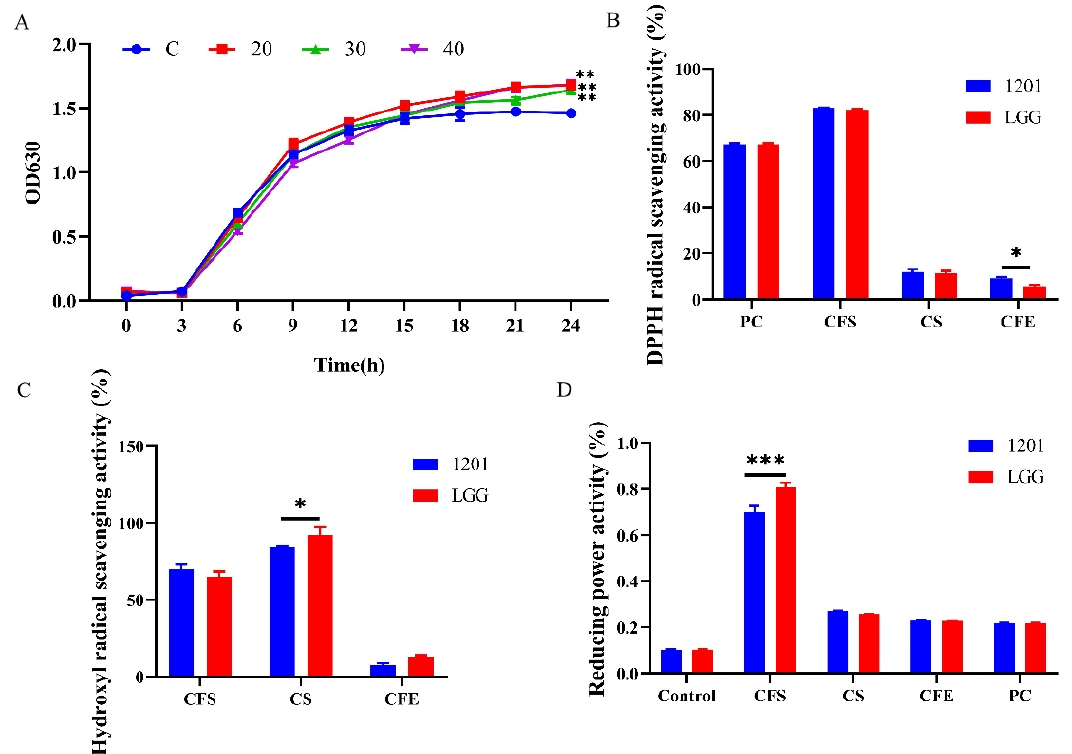
Figure 1. GOS promoted the growth of L. plantarum 1201 with high-quality antioxidant power. ( A ) Growth curve of L. plantarum 1201 in GOS treatment mediums and the MRS medium. ( B ) Picrylhydrazyl free radical (DPPH) radical scavenging assay (%) of L. plantarum 1201 . ( C ) Hydrogen peroxide capacity (%) on L. plantarum 1201 . ( D ) Reducing power concentration on L. plantarum 1201 . CFS, cell-free supernatants group; CS, cell supernatants group; CFE, cell-free extracts group; PC, Positive control group. * p < 0.05; ** p < 0.01; *** p < 0.001; * is compared with C in Figure 1A; paired two-tailed t -test.